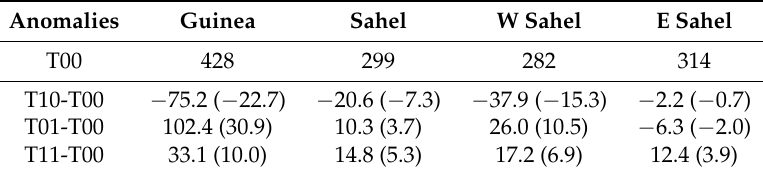
Figure 5. JAS cumulative rainfall anomalies for the three sensitivity experiments with respect to the control simulation averaged over the study period. Numbers in the bottom left corner are study domain (WA) mean absolute and relative (in parenthesis) anomalies. Table 2. JAS cumulative rainfall (mm) for the control simulation (T00) and sensitivity experiment anomalies with respect to the control simulation. Relative anomalies (%) are displayed in